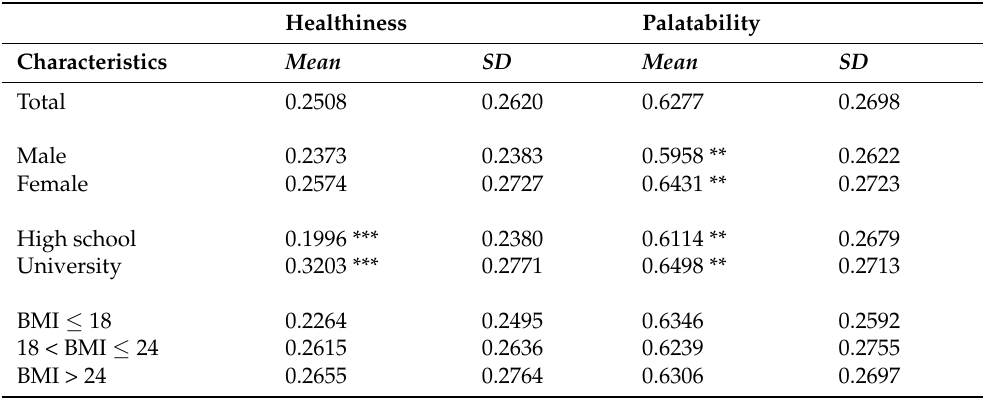
Table 2. The mean β of healthiness and palatability in the participants’ choice to eat.